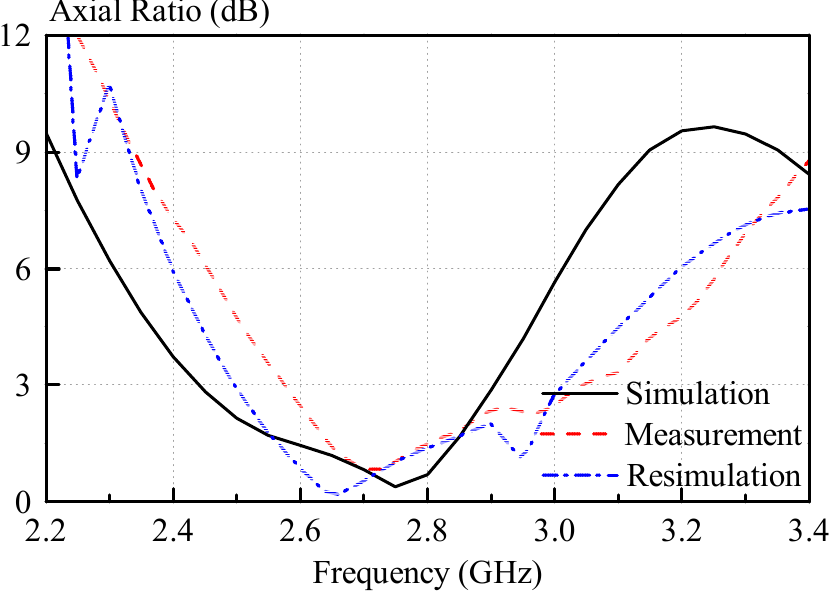
Figure 13. Measured and simulated axial ratios of the right hand circularly polarized antenna. Measured and simulated axial ratio bandwidths of 16.7% and 17.6% were obtained. For the resimulation the following values have been used: a = 24mm, b = 24mm and a dielectric constant of the dielectric paste of ε r,paste =